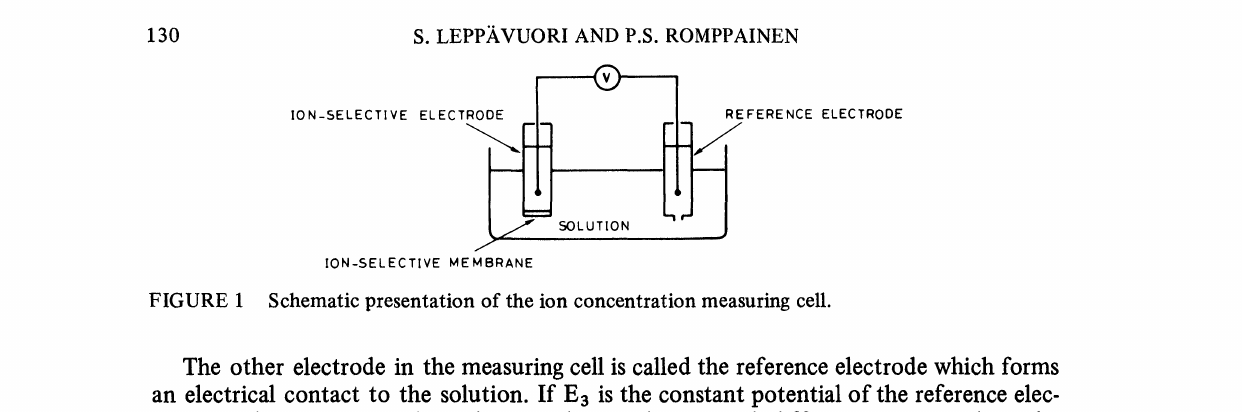
j SOLUTION ION-SELECTIVE MEMBRANE FIGURE Schematic presentation of the ion concentration measuring